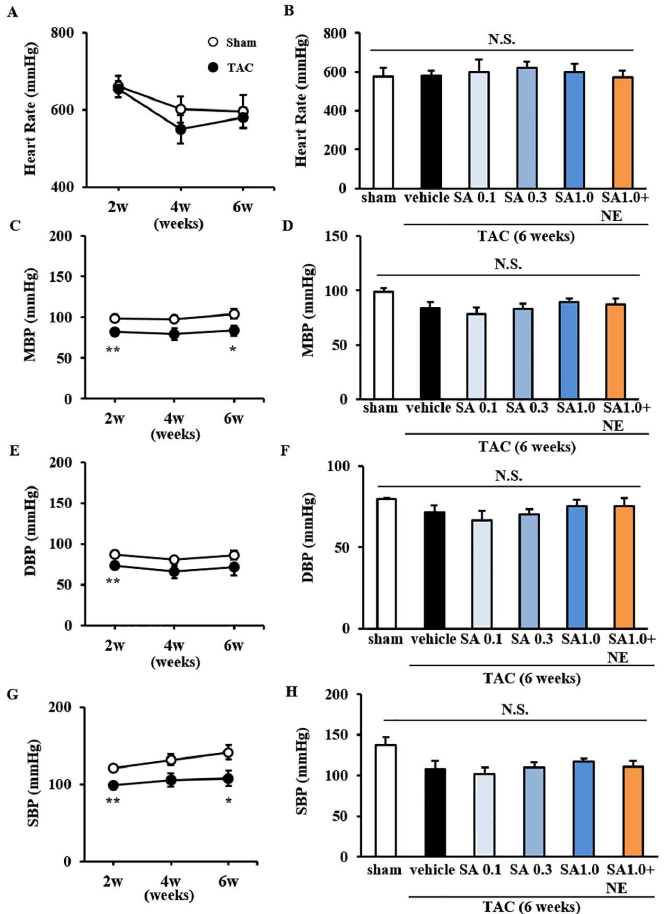
Fig 7. Effect of SA4503 treatment on sympathetic nervous activity as indicated by peripheral blood pressure. Measurement of peripheral blood pressure using the tail-cuff method. A, B: Heart rate (HR) was measured 2, 4 and 6 weeks after TAC surgery (A), and at 6 weeks with or without drug treatment for the last 4 weeks (B). C, D: Mean Blood Pressure (MBP) was measured at the same time points (C) with or without drug treatment for the last 4 weeks (D). E, F: Diastolic Blood Pressure (DBP) was similarly measured (E) with or without drug treatment for the last 4 weeks (F). G, H: Systolic Blood Pressure (SBP) was similarly measured (G) with or without drug treatment for the last 4 weeks (H). TAC mice were treated with SA4503 (0.1, 0.5 or 1.0 mg/kg) or SA4503 (1.0mg/kg) plus NE-100 (1.0 mg/kg), as indicated.Groups consisted of 6 mice. Columns represent means ± S.E.M. F (5, 28) = 0.216, P = 0.953 (HR); F (5, 28) = 1.821 (MBP); F (5, 28) = 1.144, P = 0.361 (DBP); F (5, 28) = 2.288, P = 0.730 (SBP). * , P < 0.05 and ** , P < 0.01 versus the sham